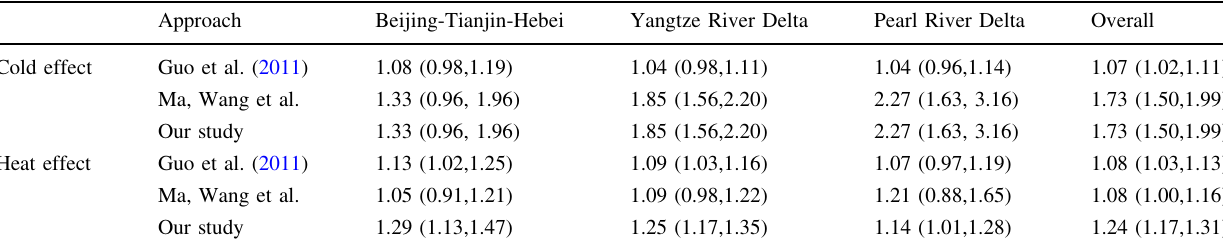
Table 3 The calculated cold/heat effects for nonaccidental mortality of the three city clusters using different methods